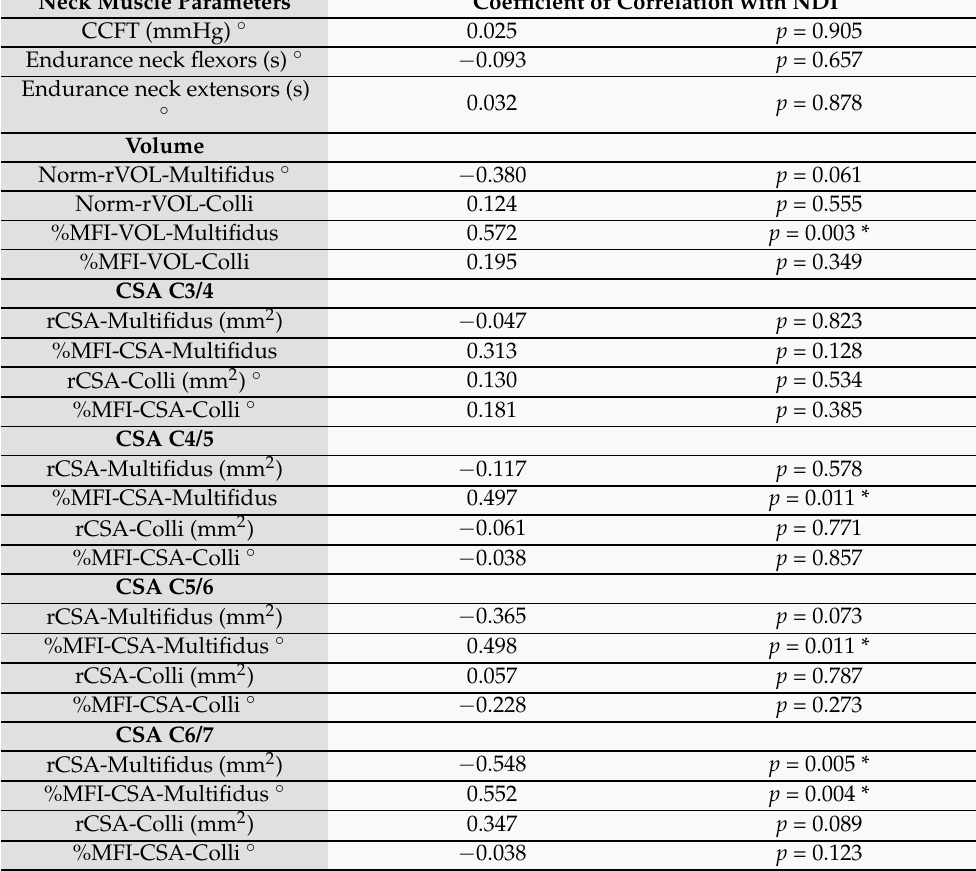
Table 5. Correlation between muscle parameters and neck disability index. Neck Muscle Parameters Coefficient of Correlation with